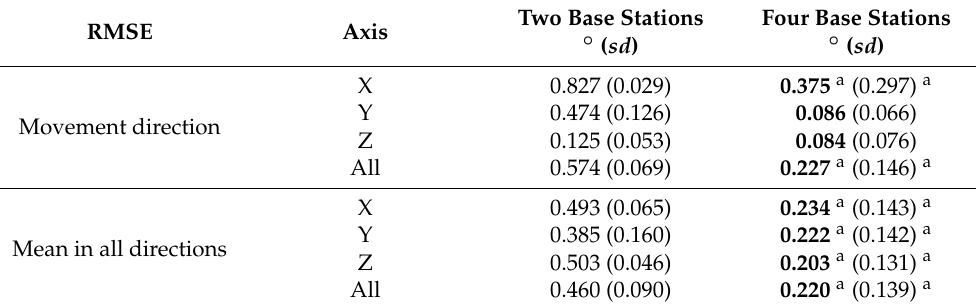
Table 3. Errors ( ◦ ) in tracking of rotation with standard deviations ( sd ), five measurement runs for each movement, and the best results are highlighted. Two Base Stations Four Base Stations RMSE Axis ◦ ( sd ) ◦ ( sd )